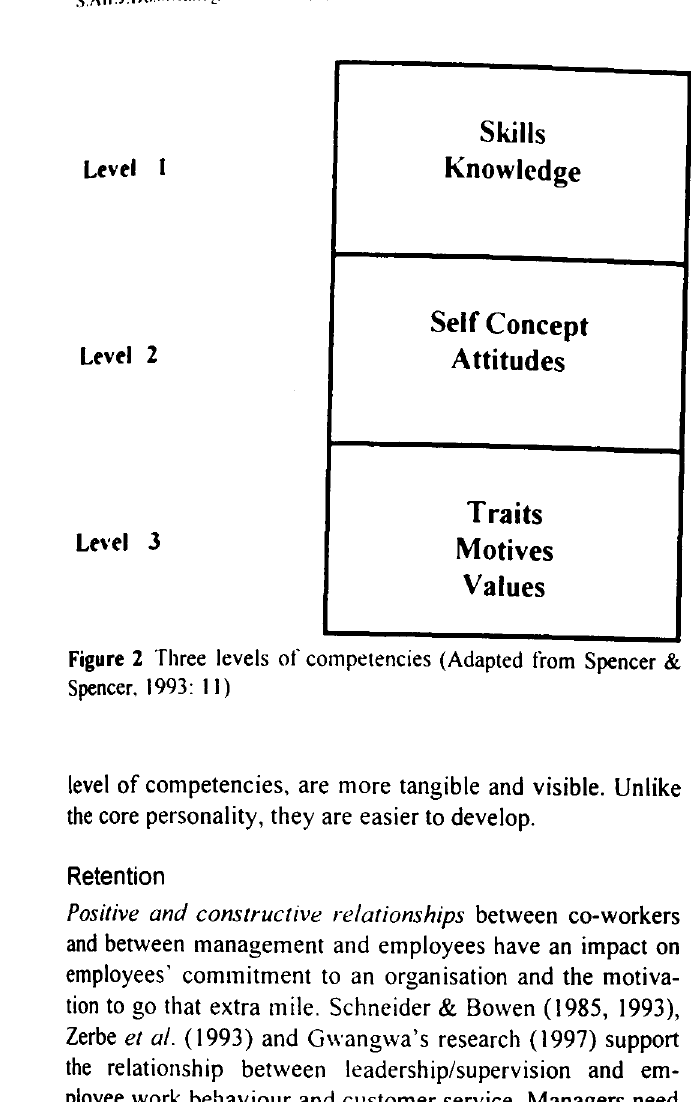
Figure 2 Three levels of competencies (Adapted from Spencer & Spencer. 1993: 11)